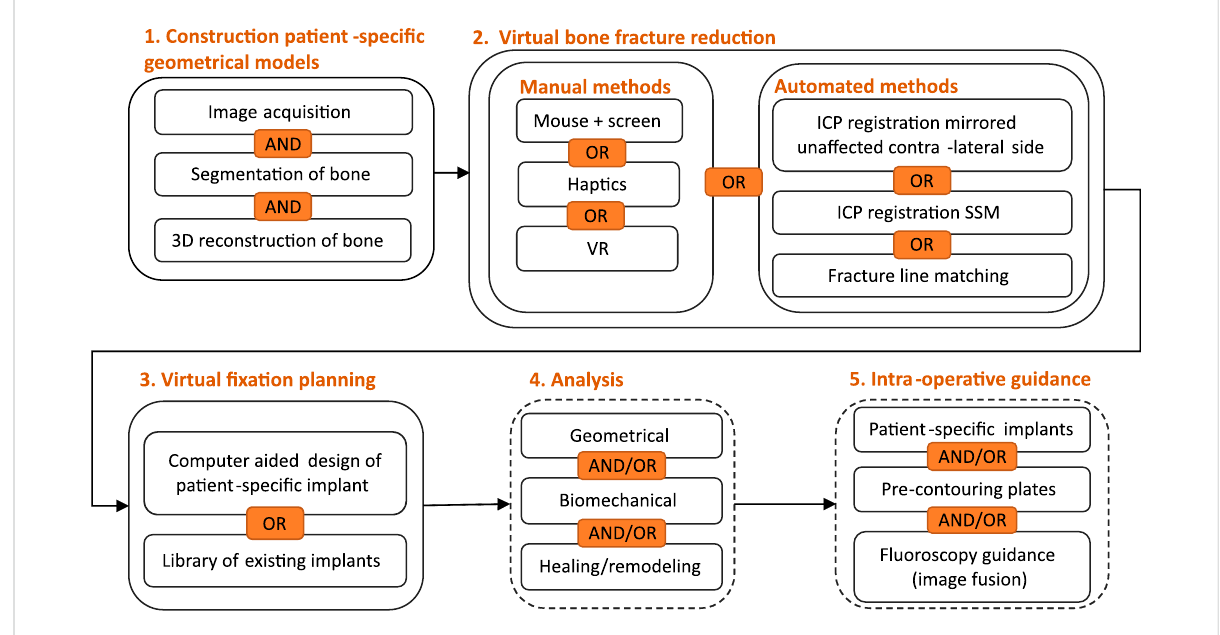
FIGURE 3 Flow diagram of different stages of computer-assisted preoperative planning of bone fracture fi xation, including different approaches for each stage. VR, virtual reality; ICP, iterative closest point; SSM, statistical shape